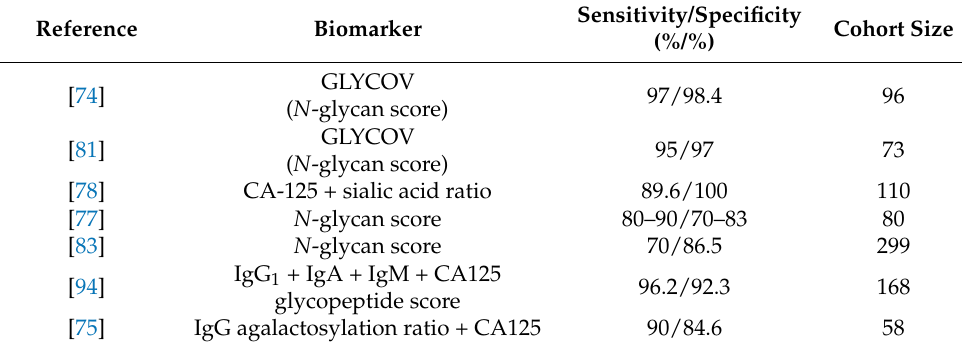
Table 5. Diagnostic performances reported for glycan-based